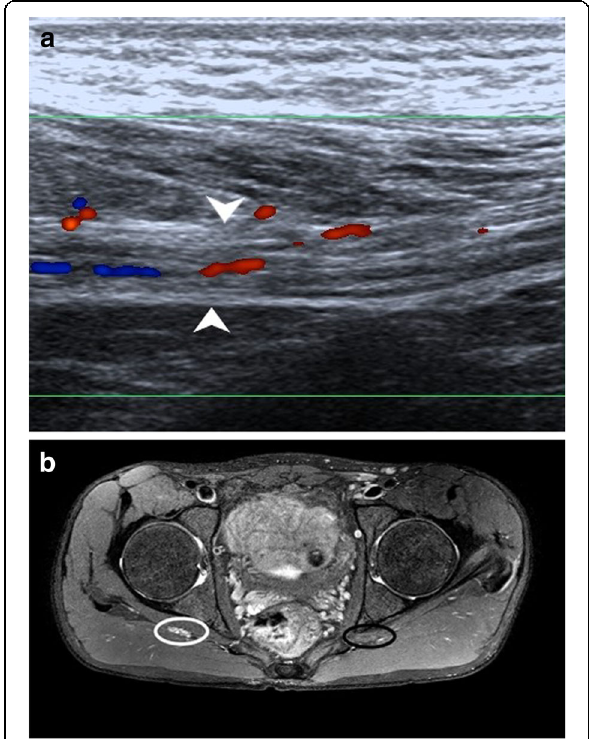
injection palsy. b PDFS axial image shows hyperintensity in the right sciatic nerve (white circle) with opposite normal sciatic nerve (black circle)